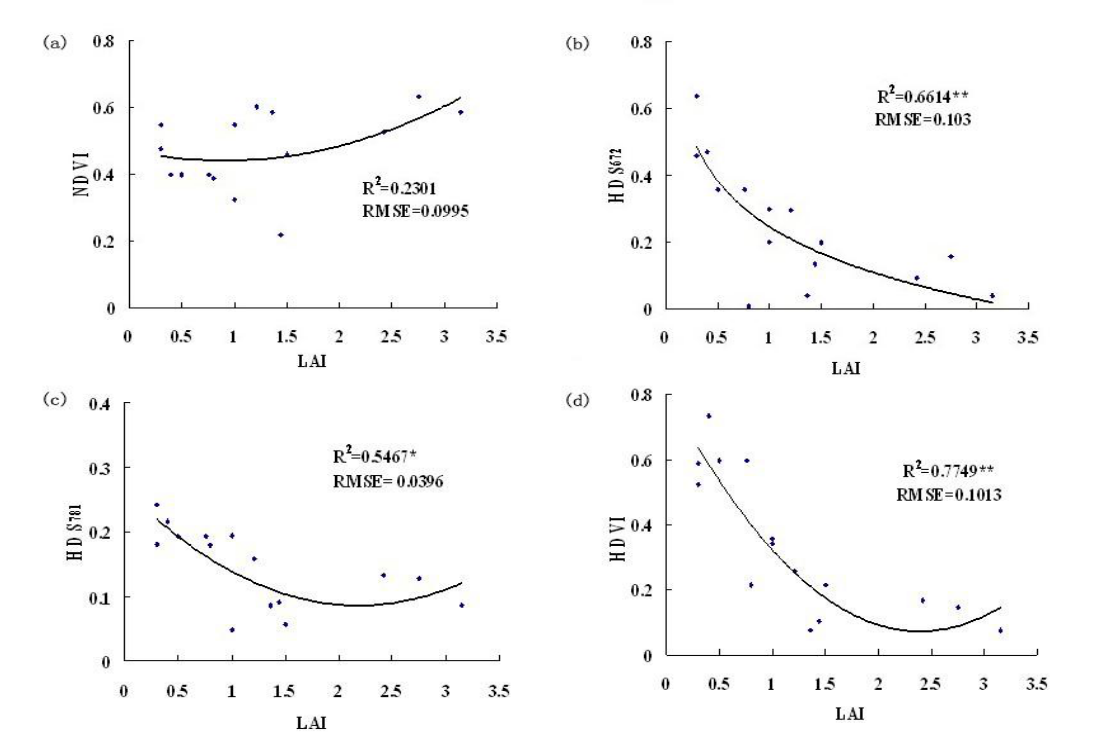
Figure 5. Correlationship between LAI and (a)HDS 670 , (b)HDS 800 , (c)NDVI, and (d)HDVI using CHRIS/PROBA data ( significance level of the relationship is indicated: **P<0.05,